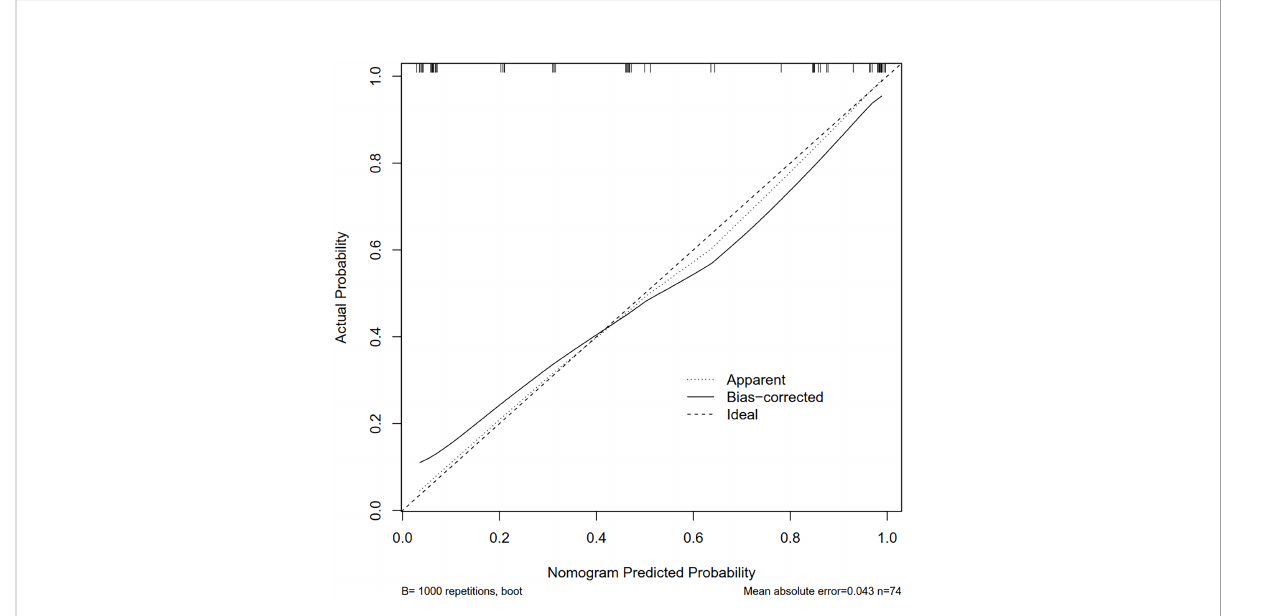
FIGURE 3 The calibration curves for the nomogram. The x-axis represents the nomogram-predicted CLNM probabilities, and y-axis represents the actual probability of CLNM. Perfect prediction would be along the 45-degree line. The solid curve is bias-corrected by bootstrapping (B = 1,000 repetitions), indicating the observed nomogram performance. CLNM, cervical lymph node metastasis; MTC, medullary thyroid carcinoma.